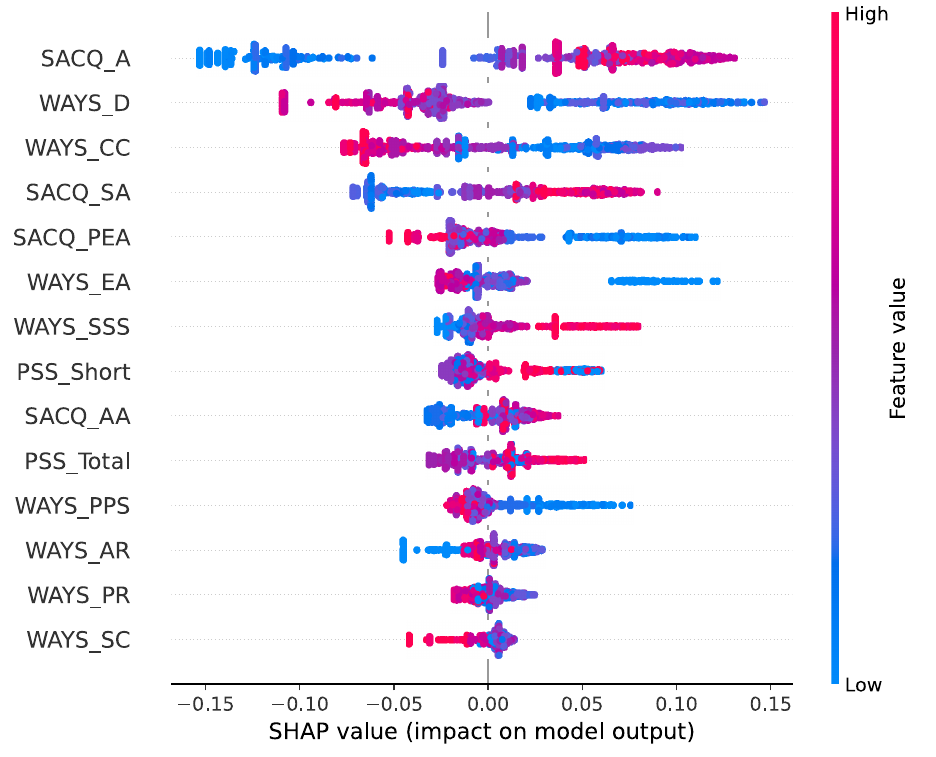
Fig 5. SHAP plot for covid-19 regulations response using the random forest